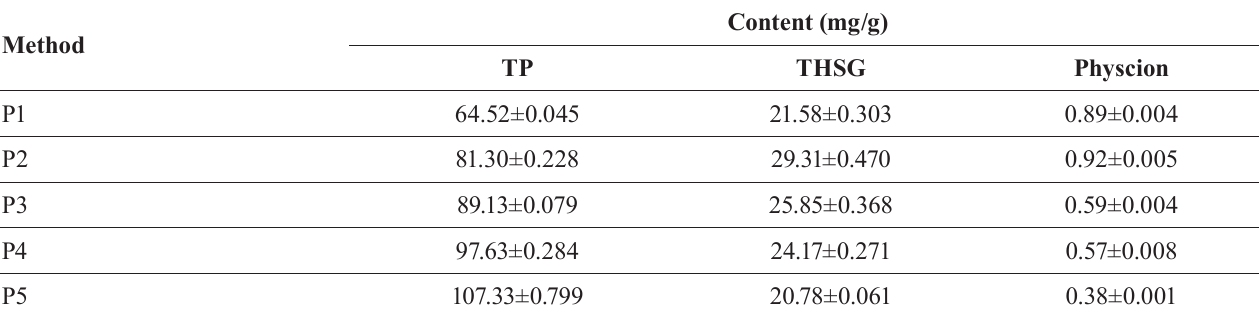
P1 were 64.52±0.045, 21.58±0.303, 0.89±0.004 mg/g, respectively and those in the sample P2 were 81.30±0.228, 29.31±0.470, 0.92±0.005 mg/g, respectively (refer Table TABLE I - T P, THSG, and physcion contents in the FMT products processed at different conditions. Data were represented as mean ± S.D. of three independent experiments performed in triplicates